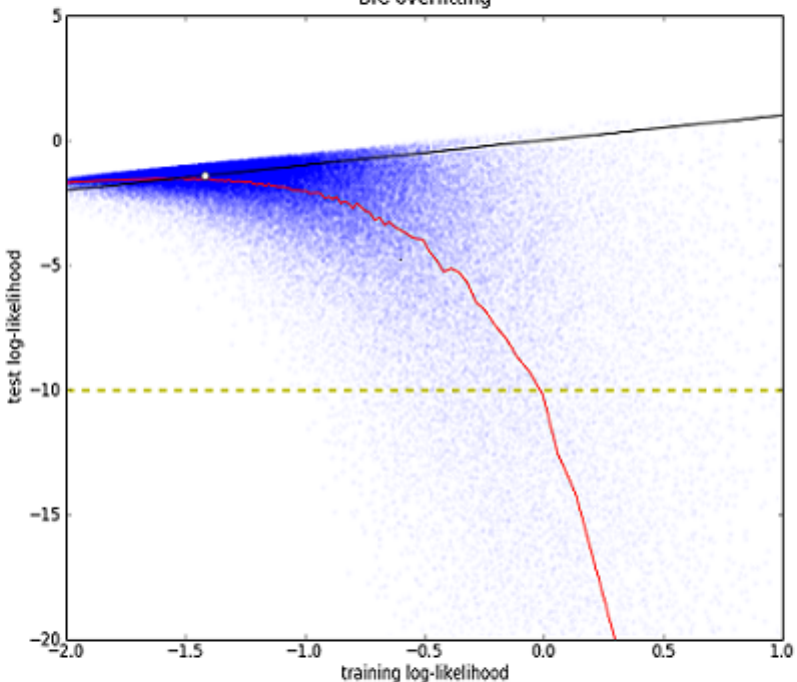
Figure 1. Overfitting analysis of BIC models on a small sample from a normal distribution. For each data point, a sample of three observations was drawn randomly from a unit normal distribution. The BIC-optimal model was fit to these observations and used to compute the training vs. test log-likelihoods L vs. L , the latter calculated on an additional test sample of three observations e drawn from the same unit normal. To generate the scatter plot, this process was performed a total of N = 100000 times. The mean value of L for successive e windows of 1000 observations sorted from left to right is plotted in red. The zero-bias line is shown in black ( L = L ). Thus, the overfitting bias information e I is given at any position on the graph by the vertical distance between the black b and red lines. The white circle indicates the true expectation log-likelihood for the unit normal distribution. The dotted line marks the mean value of L averaged e over all 100,000 data points. Note that this figure shows only a portion of the full distribution, which has a long tail extending to large negative values of L e